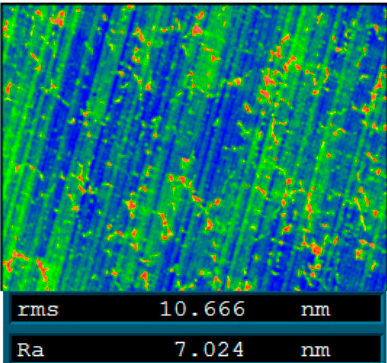
Figure 16. Surface roughness of the mirror.